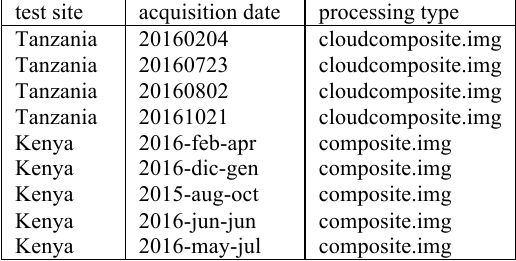
Table 1. S2 MSI images utilised in this study